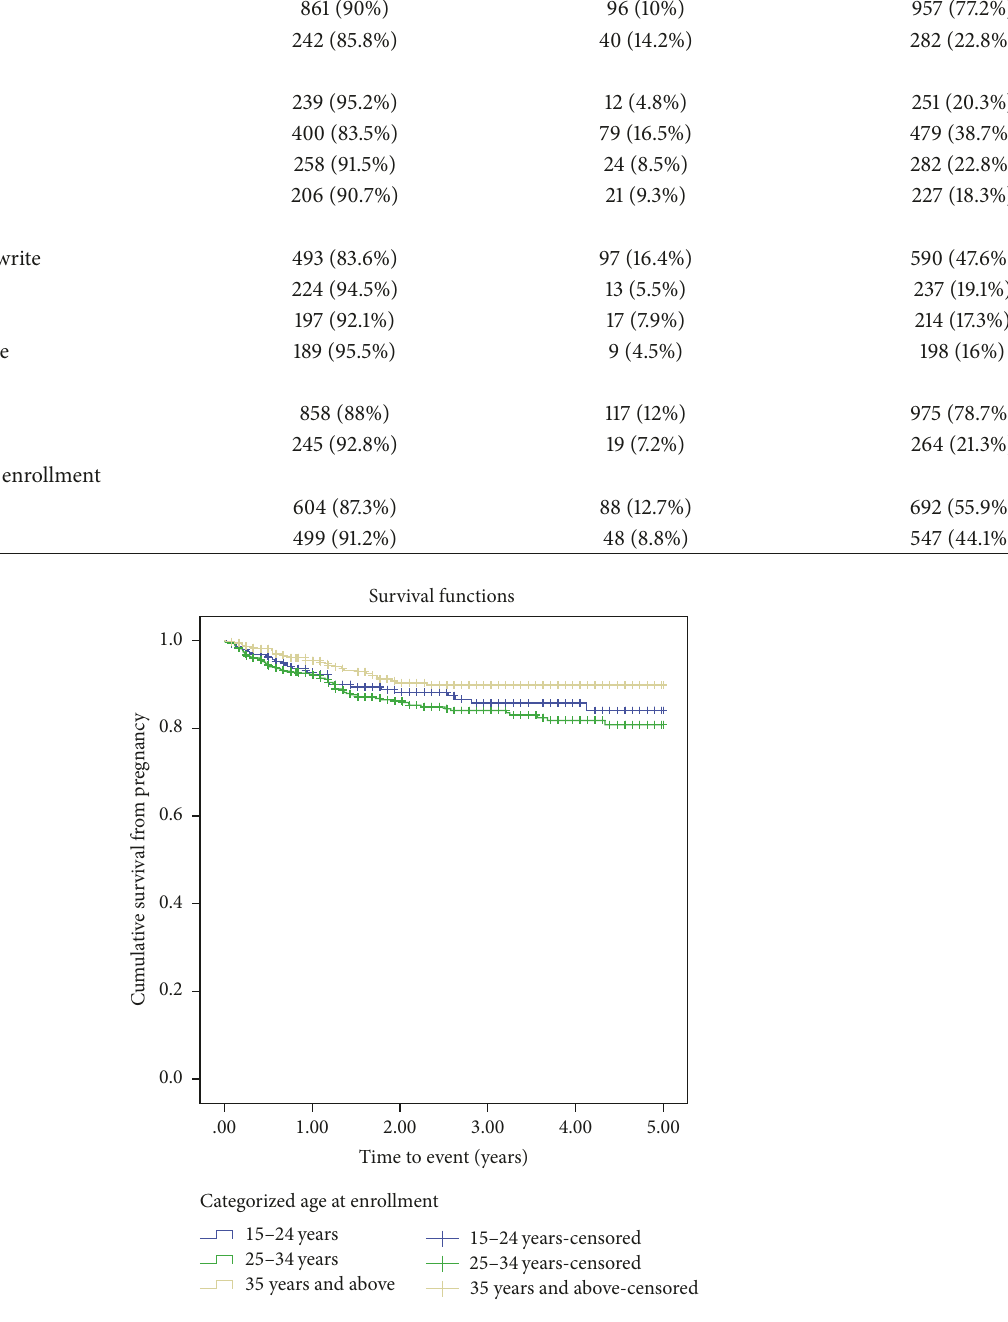
Figure 1: Kaplan-Meier curves of pregnancy comparing age among women receiving ART treatment from Sep. 2011 to Aug. 2015 in Debre Markos Referral Hospital, Northwest Ethiopia, 2016 ( 𝑁 = 1 , 239